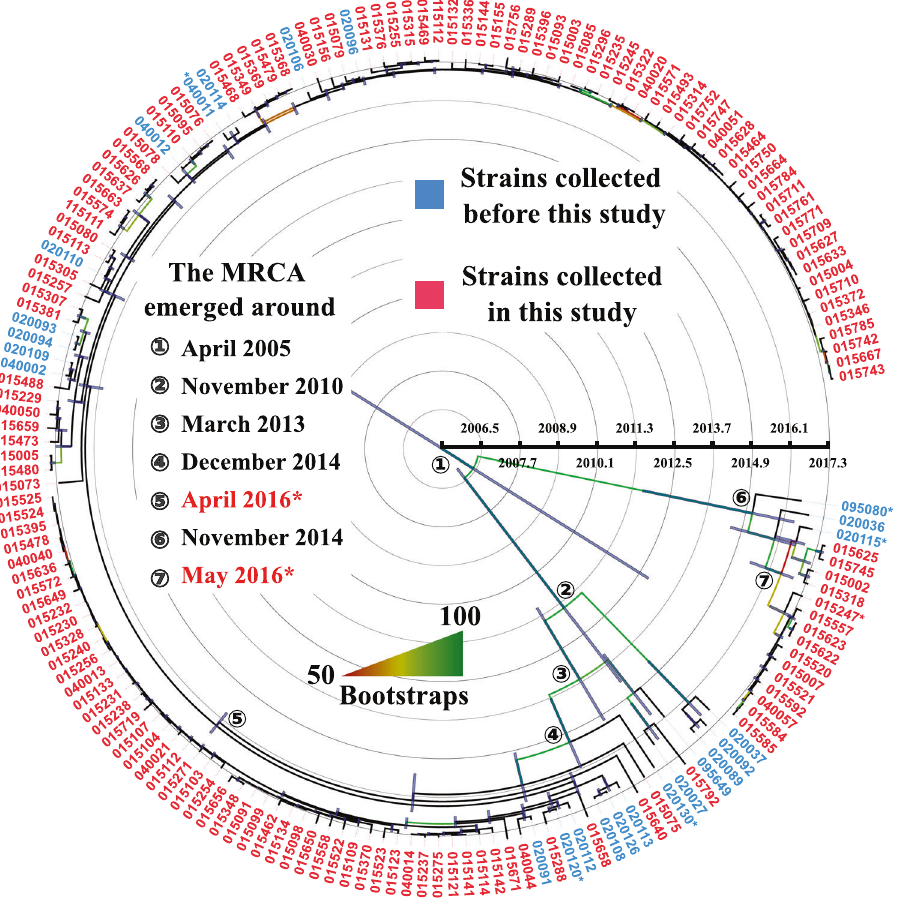
Fig. 3 The time-calibrated phylogenetic tree of 171 strains of ST11 KL64 CRKP isolates in this study and collected in the hospital before the study. The dating was performed based on the maximum-likelihood tree inferred from core SNP sites under GTR model with site rate variation and a 1,000-bootstrap test. Strains collected in and before this study were highlighted in red and blue, respectively. Branches with bootstrap support over 50% were coloured in gradient and the average nucleotide substitution rate was estimated to be 4.85 per genome per year. MRCA refers to the most recent common ancestor. The 95% con fi dence intervals of estimated dates are as below: 1. October 1991 to May 2012; 2. November 2004 to February 2014; 3. May 2010 to November 2014; 4. May 2013 and December 2015; 5. September 2015 and July